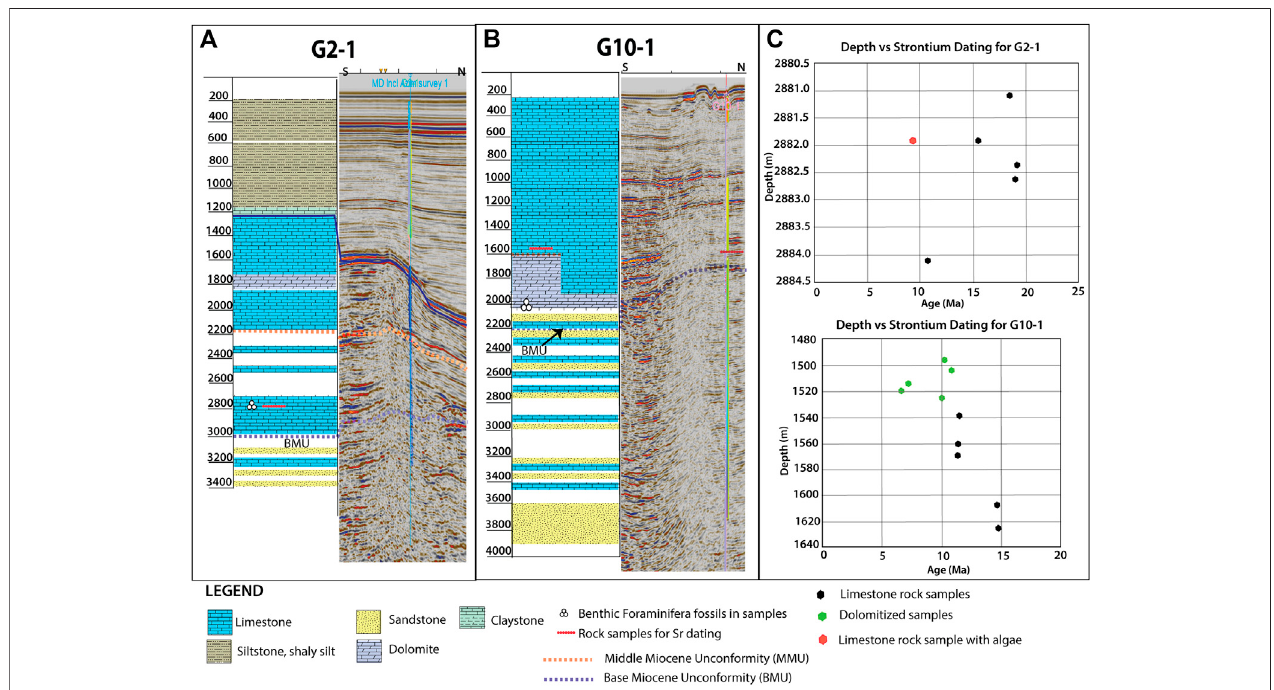
FIGURE 11 | (A) Lithological interpretation and snapshot of well-seismic calibration for G2-1 well showing the top of limestone at Cycle V/VI boundary. (B) Core interpretation and snapshotofwell-seismic calibrationforG10 – 1well. Lines locationarepresentedin Figure 1B . (C) Strontium isotopedatingfor G2-1 and G10 – 1core samples (highlighted depth) from Allan et al., 2009. Rock samples from G2-1 (depth 2,881.4 to 2,884.2 m) yield age of 17.0 – 19.8 Ma while rock samples from G10 – 1 (depth 1,540 to 1,640 m) gives age between 11.0 to 14.9 Ma. Benthic foraminifera found in the samples are labeled in (A,B) , as cross-check for the strontium isotope